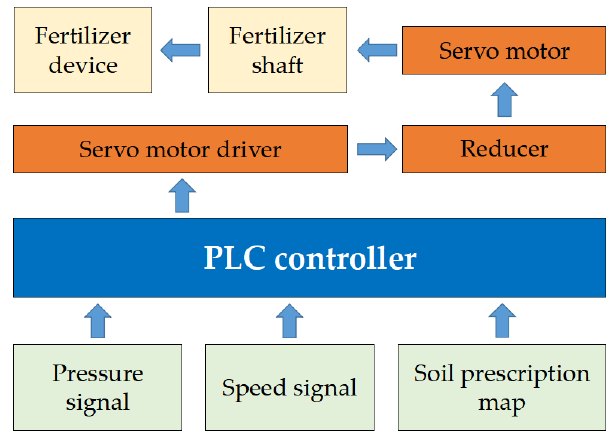
Figure 5. Structural block diagram of fertilizer driving system.